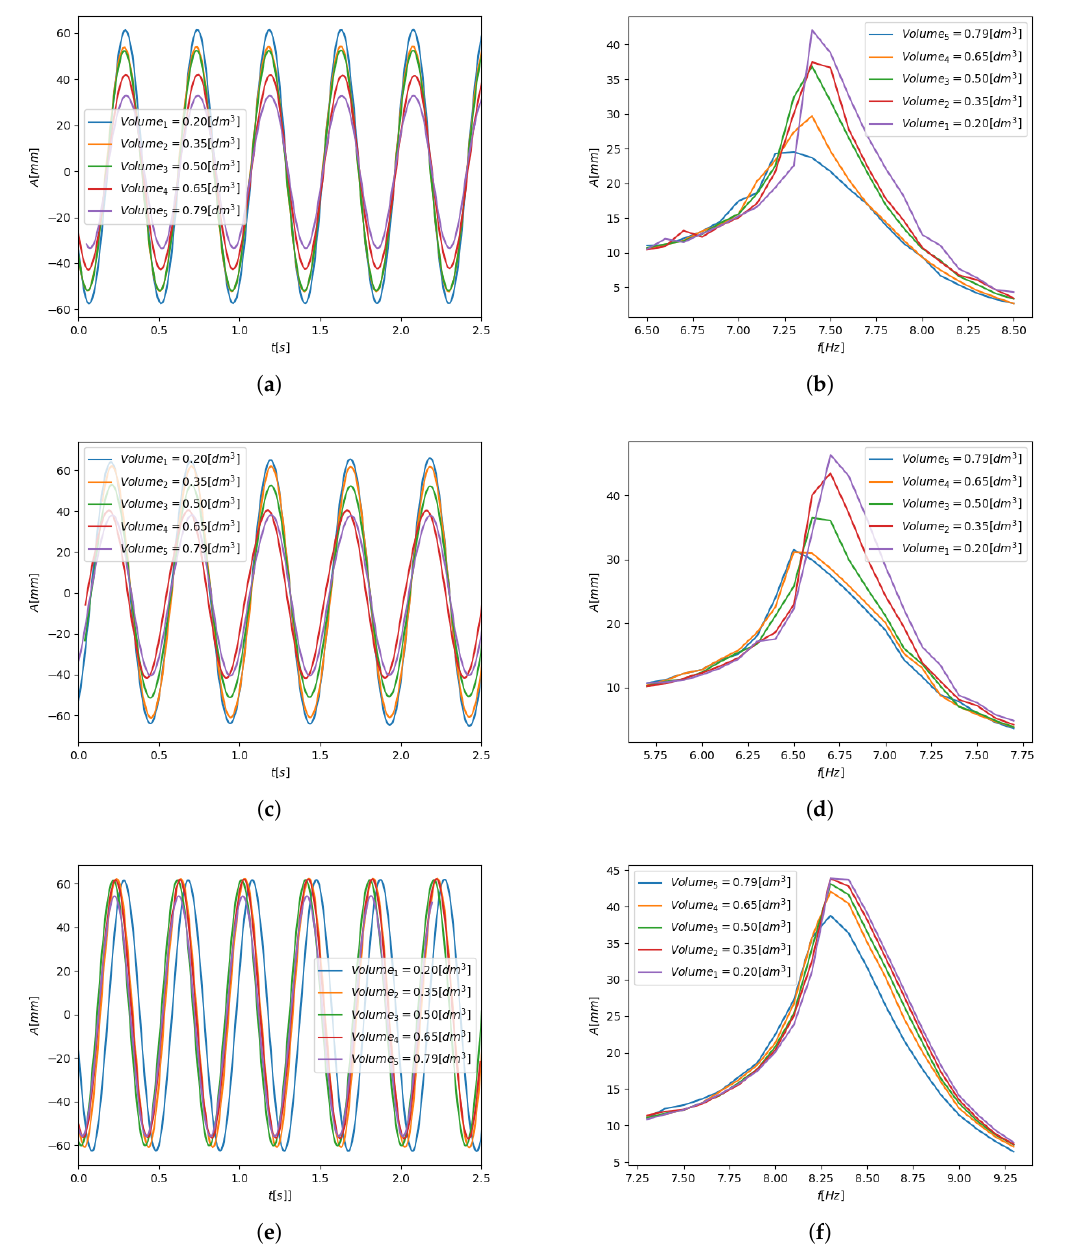
Figure 5. Displacement waveforms ( a , c , e ) and RMS values ( b , d , f ) for various granular grains compositions. ( a ) Displacements of the beam— M p = 0.1 M s ; ( b ) RMS of beam displacements— M p = 0.1 M s ; ( c ) Displacements of the beam— M p = 0.2 M s ; ( d ) RMS of beam displacements— M p = 0.2 M s ; ( e ) Displacements of the beam— M p = 0.05 M s ; ( f ) RMS of beam displacements— M p = 0.05 M s